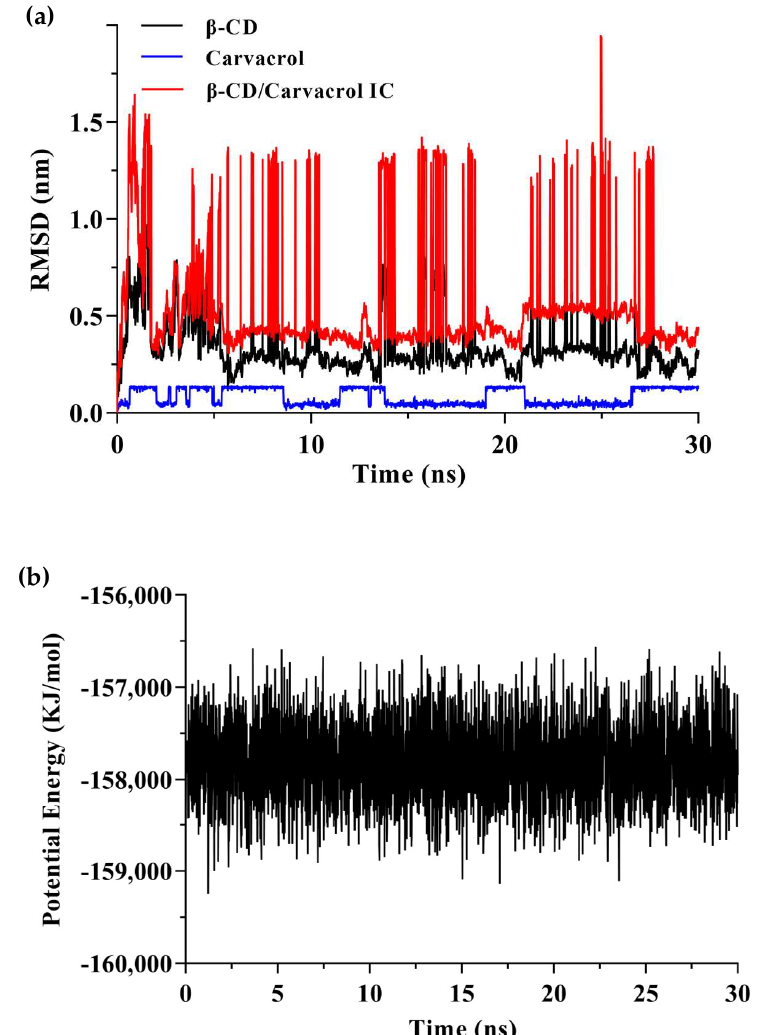
Figure 10. The results of molecular dynamics simulation. ( a ) The RMSD of the β − CD/carvacrol IC during 30 ns simulation; ( b ) The variation in potential energy of the β − CD/carvacrol IC during 30 ns simulation.